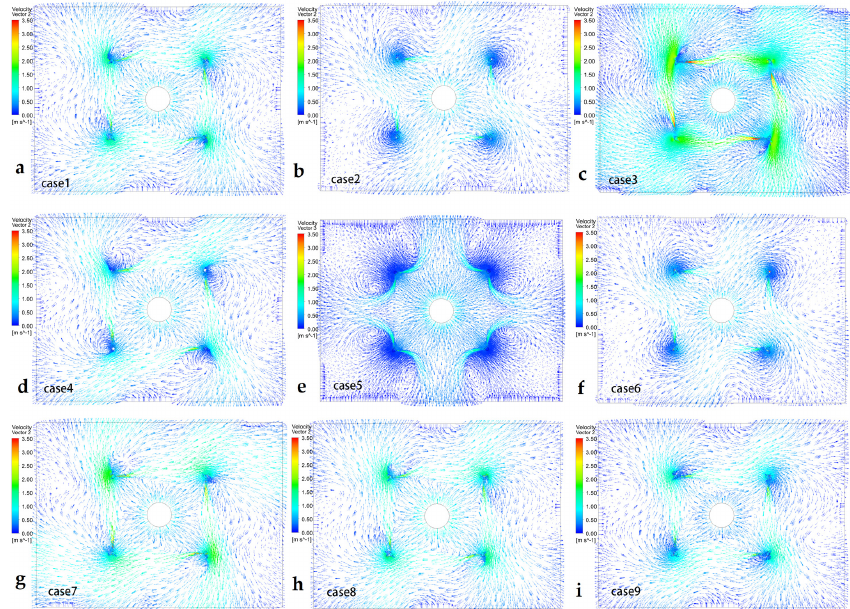
Figure 13. Distributions of velocity vectors under various air curtain parameters: ( a ) case 1 (blow and suction; 20 mm; 5 m/s; 0.8 m/s); ( b ) case 2 (blow and suction; 10 mm; 5 m/s; 0.8 m/s); ( c ) case 3 (blow and suction; 40 mm; 5 m/s; 0.8 m/s); ( d ) case 4 (unilateral blowing; 20 mm; 5 m/s; 0.8 m/s); ( e ) case 5 (bilateral blowing; 20 mm; 5 m/s; 0.8 m/s); ( f ) case 6 (blow and suction; 20 mm; 3.5 m/s; 0.8 m/s); ( g ) case 7 (blow and suction; 20 mm; 6.5 m/s; 0.8 m/s); ( h ) case 8 (blow and suction; 20 mm; 5 m/s; 1.1 m/s); ( i ) case 9 (blow and suction; 20 mm; 5 m/s; 0.5 m/s).